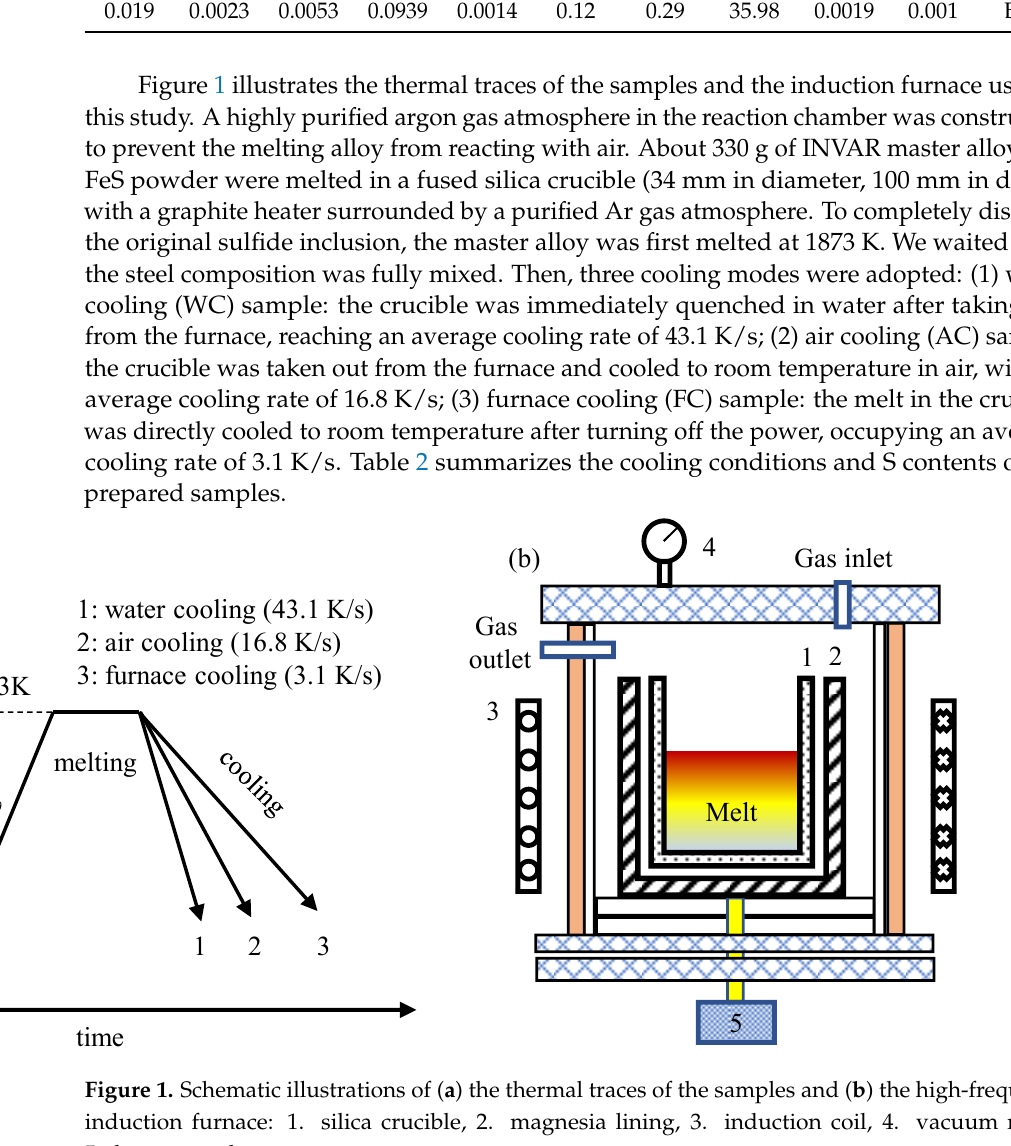
Figure 2. Schematic representation of sampling locations in steel samples. 2.2. Thermodynamics of Sulfide Precipitation Process The formation of inclusions of CaS may occur during solidification. The equilibrium reactions are expressed as follows [39,40].